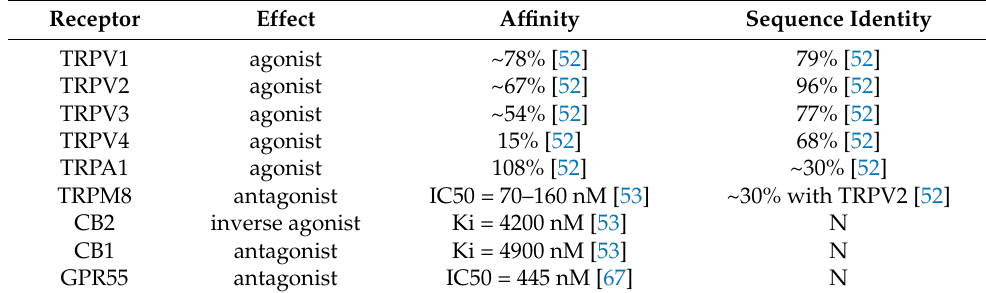
Table 1. Affinity of the receptors to